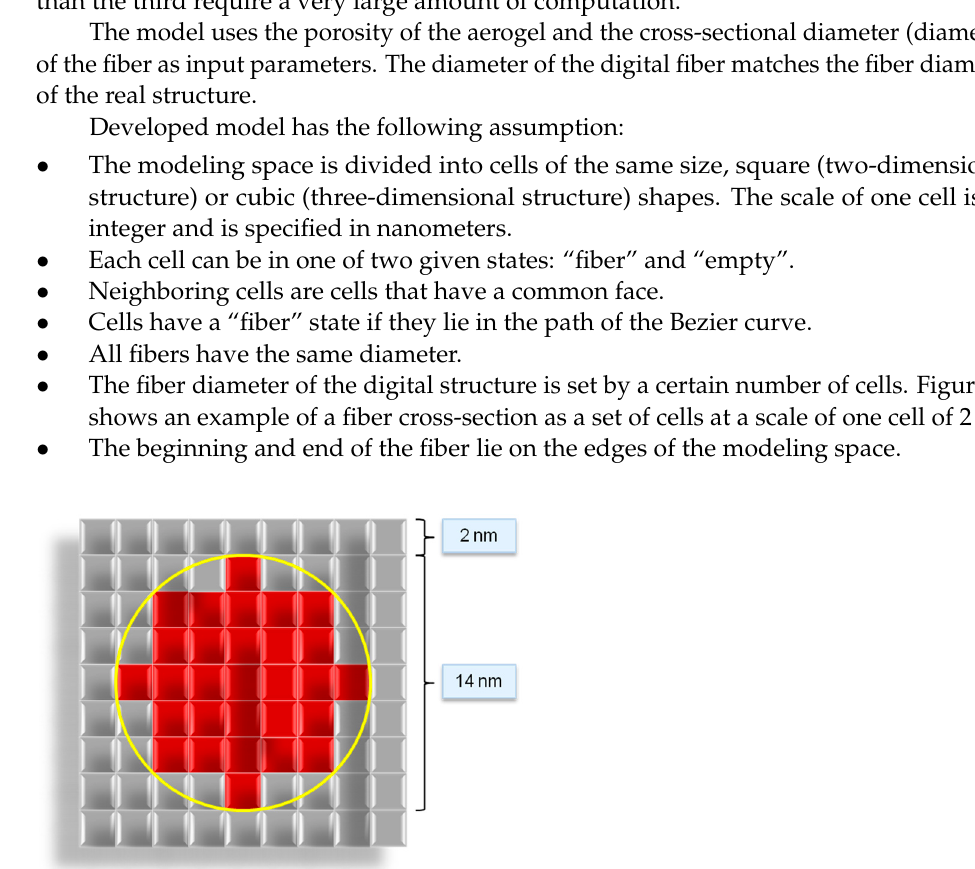
—“fiber” cells, —“empty” cells, — control points, —Bezier curves Figure 12 shows the control points P (cid:2868) , P (cid:2869) , P (cid:2870) , P (cid:2871) selected on the modeling field. A Bezier curve is constructed from these points, and cells on its path are set into the “fiber” state. After that, the fiber increases its diameter to the specified value. The algorithm for increasing the fiber diameter works as follows: a sphere (circle for a two-dimensional case) with a diameter equal to the input fiber diameter is formed around each point of the fiber. All cells inside the sphere (circle) are set into the “fiber” state (Figure 13):